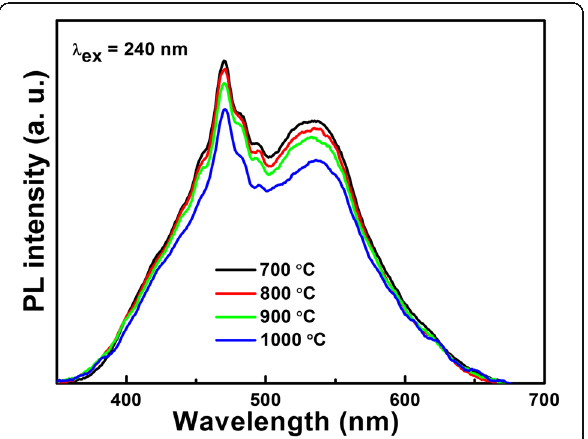
Fig. 4 Room temperature PL spectra of the LiNb 3 O 8 photocatalysts